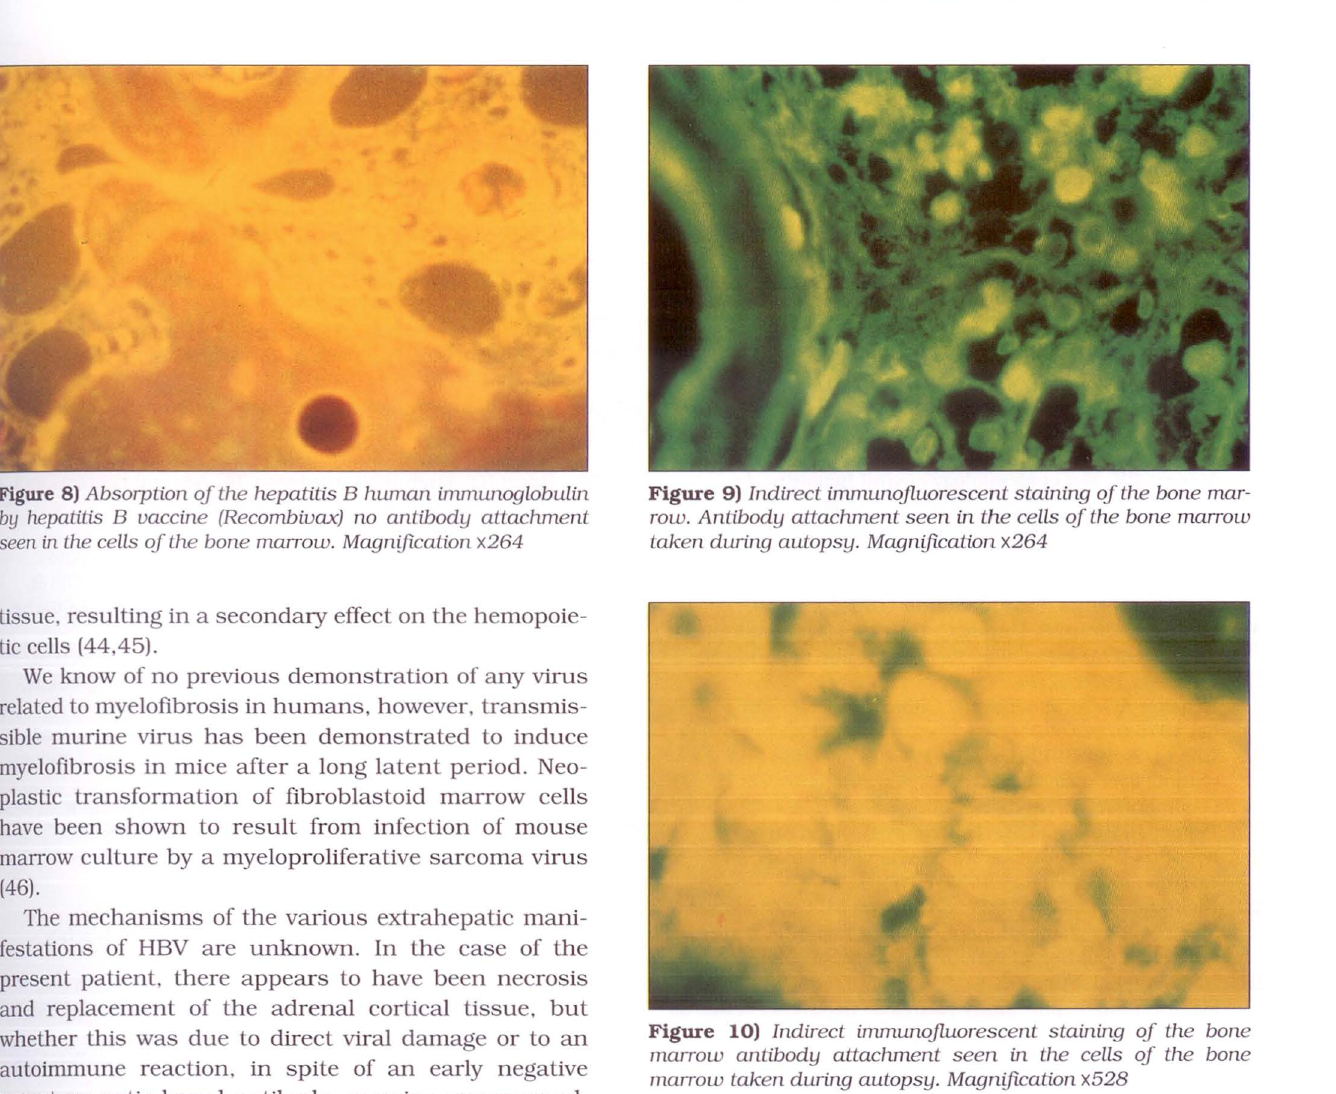
progress. Good clinical studies are needed to develop better treatment modalities. Prevention of the disease by more widespread immunization nust be empha